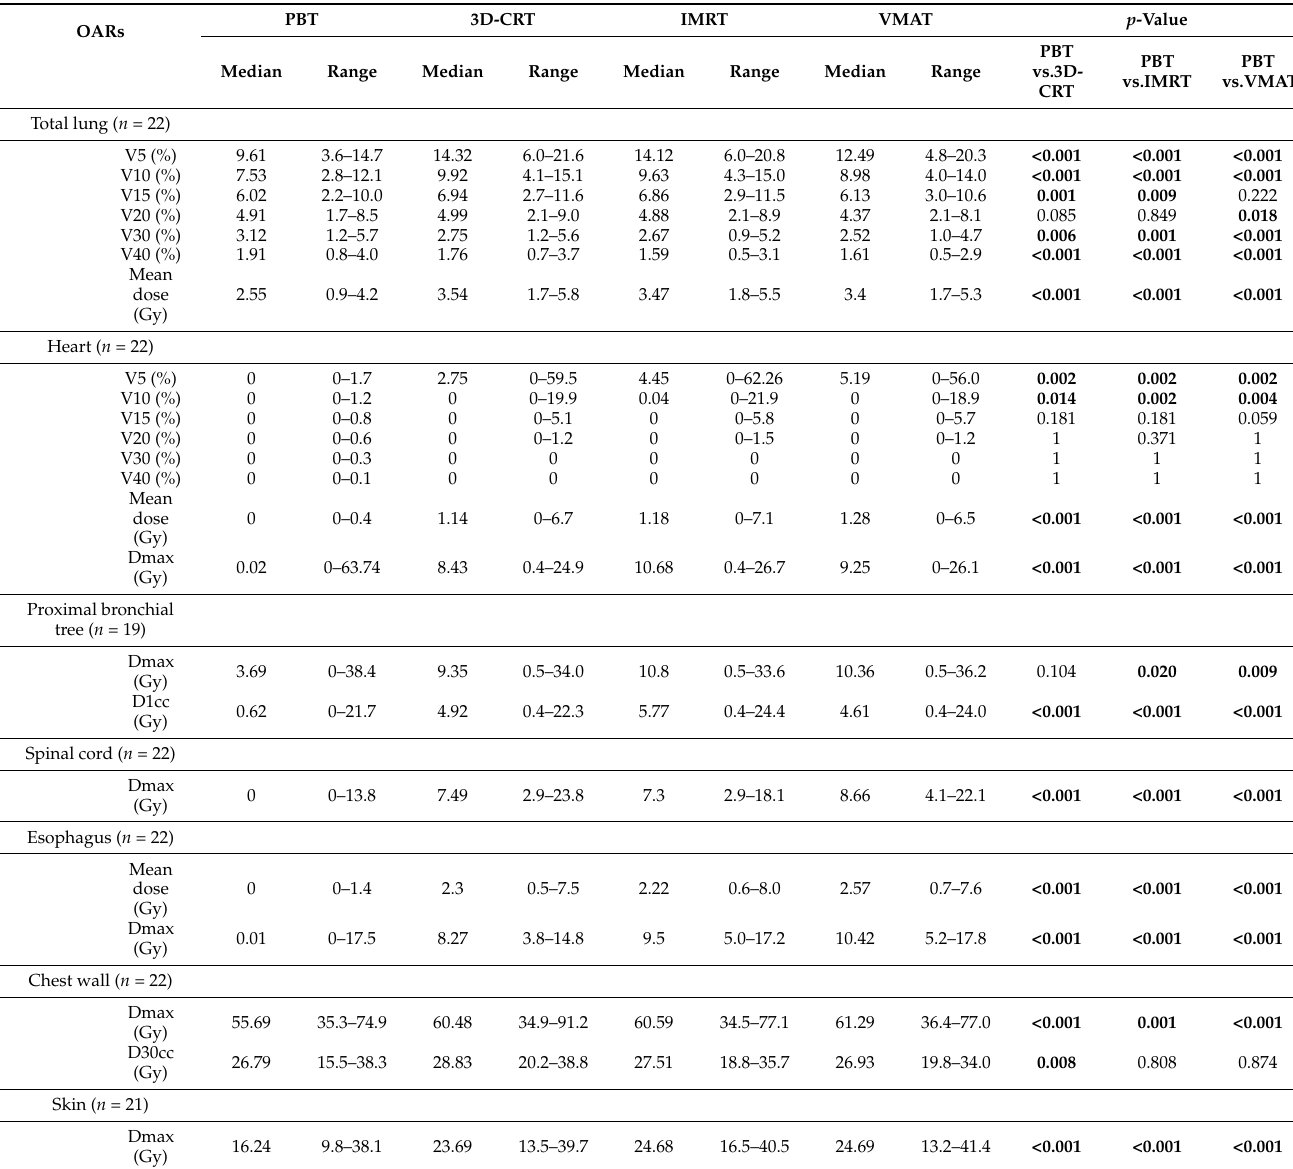
Table 4. Summary and comparison of the dosimetric parameters of tumors located close to the chest wall (60 CGE/4 fx =